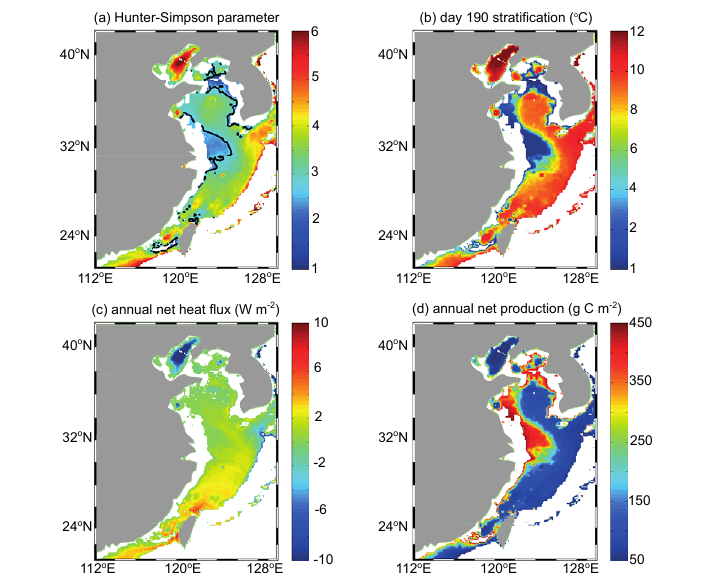
Figure 9. For the East China and Yellow seas domain in 2013: (a) Hunter–Simpson parameter, highlighting the contour delineating log 10 (h/u 3 ) = 2 . 7; (b) day 190 surface–bottom temperature difference; (c) net surface heat flux; (d) annual net